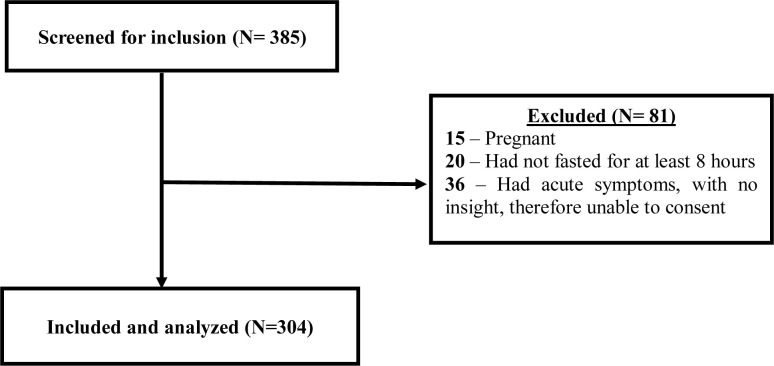
Flow chart for participants’ recruitment into the study.